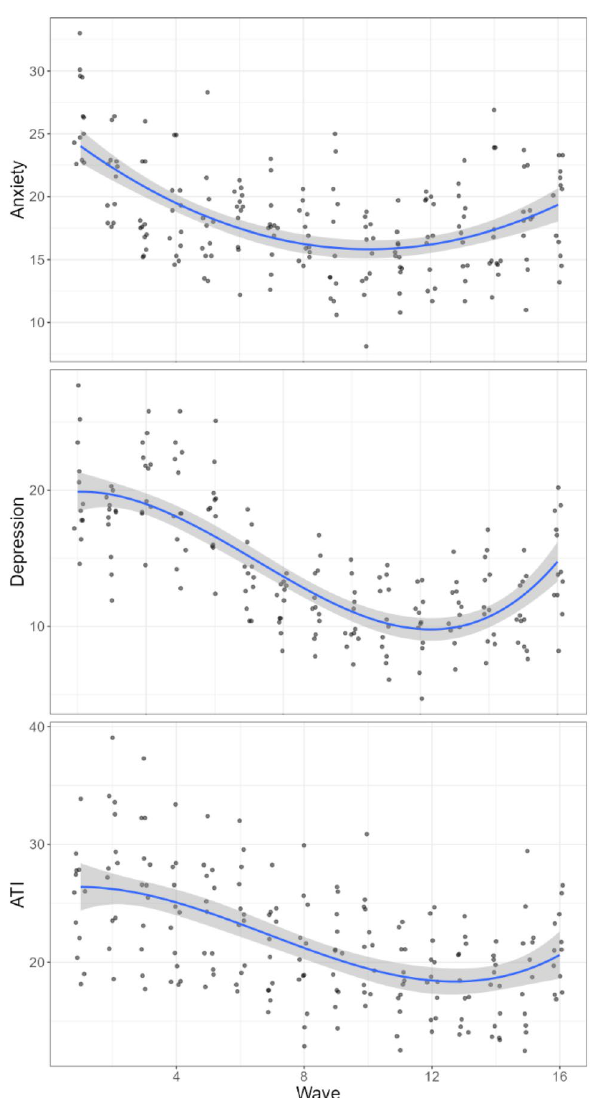
Figure 2. Chronogram for ATI, Anxiety and Depression measures across regions and over the weeks from March 23rd (wave 1) to October 19th (wave 16). Blue fitted lines represent second-order polynomial for Anxiety and third-order for ATI and depression. Grey areas represent